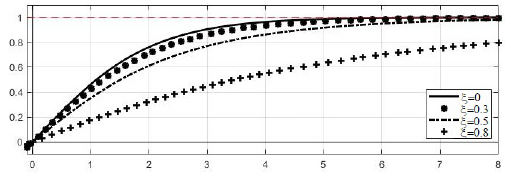
Figure 1. Graphics of the function f 1 ( β ) for various ξ .